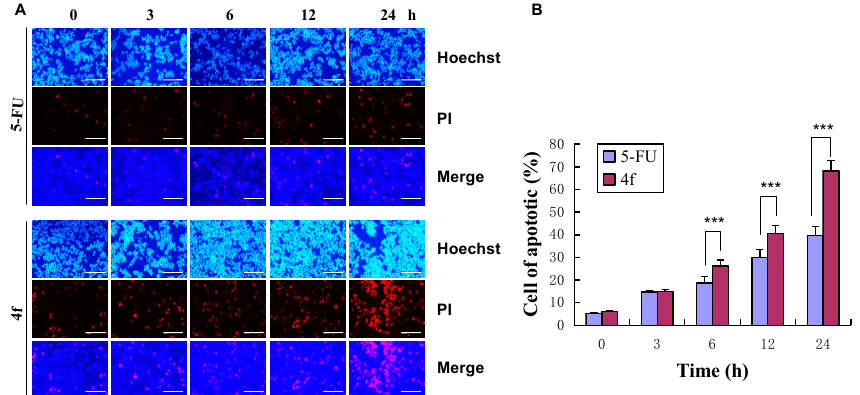
Figure 3. Apoptosis and necrosis induced by compound 4f in HeLa cells. ( A ) HeLa cells were treated with 4 µ M of 4f or 18 µ M of 5-FU for 0, 3, 6, 12, or 24 h and were stained using the Hoechst / PI solution. Morphology and fluorescence intensity were examined under a fluorescence microscope (magnification: × 200). ( B ) Quantification of the percentages of apoptotic cells. Error bars indicate the mean ± SD of three independent experiments (* p < 0.05, ** p < 0.01, and *** p < 0.001 indicate significant di ff